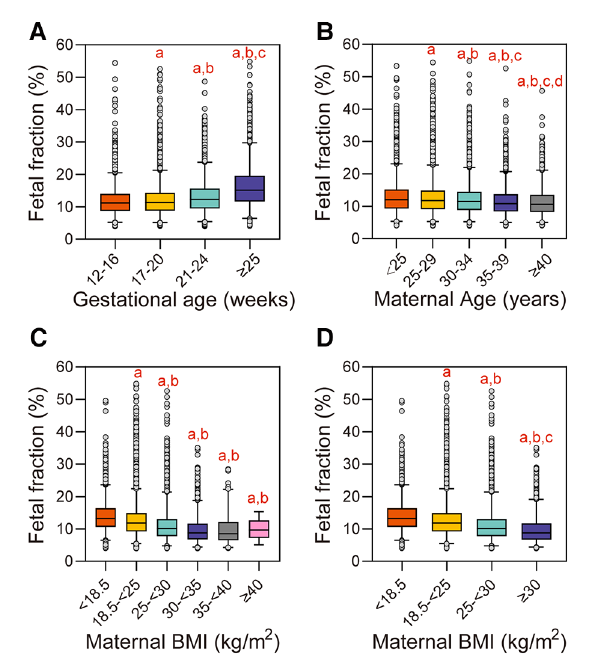
FIGURE 2 In fl uence of maternal and fetal characteristics on fetal fraction. ( A ) Gestational age. a Reference group is 12 – 16 weeks, P <0.05. b Reference group is 17 – 20 weeks, P <0.05. c Reference group is 21 – 24 weeks, P <0.05. ( B ) Maternal age. a Reference group is <25 years, P <0.05. b Reference group is 25 – 29 years, P <0.05. c Reference group is 30 – 34 years, P <0.05. d Reference group is 35 – 39 years, P <0.05. ( C ) Maternal BMI in the six groups. a Reference group is <18.5 kg/m 2